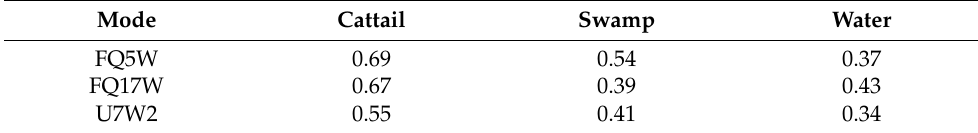
Table 8. Average coherence from April to November, 2018 for wetlands in Bay of Quinte. Mode Cattail Swamp Water FQ5W